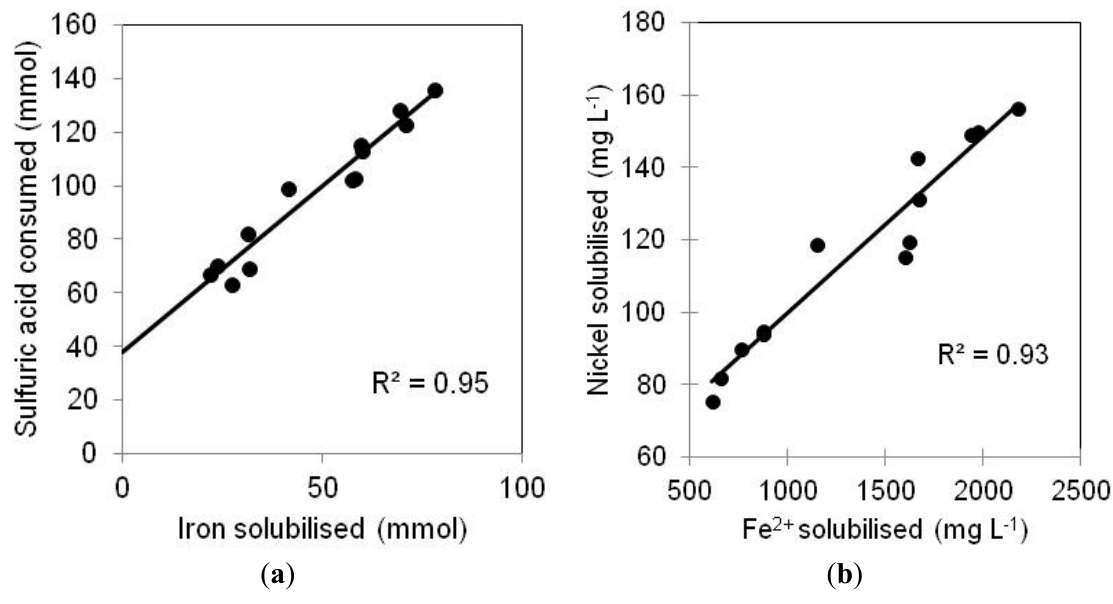
Figure 2. ( a ) Correlation between iron and nickel solubilised from Ni laterite ore by At. ferrooxidans incubated under anoxic conditions and using elemental sulphur as electron donor; ( b ) correlation between iron released from the Ni laterite ore and the amount of sulphuric acid consumed in maintaining pH at 1.9, in anoxic